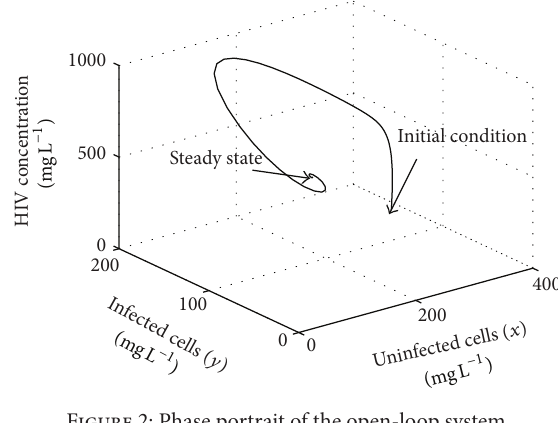
Figure 2: Phase portrait of the open-loop system.